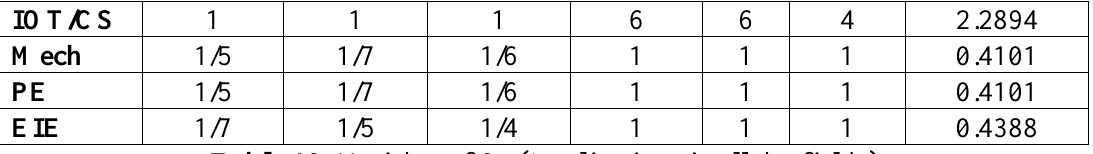
(Applications in all the fields) 6